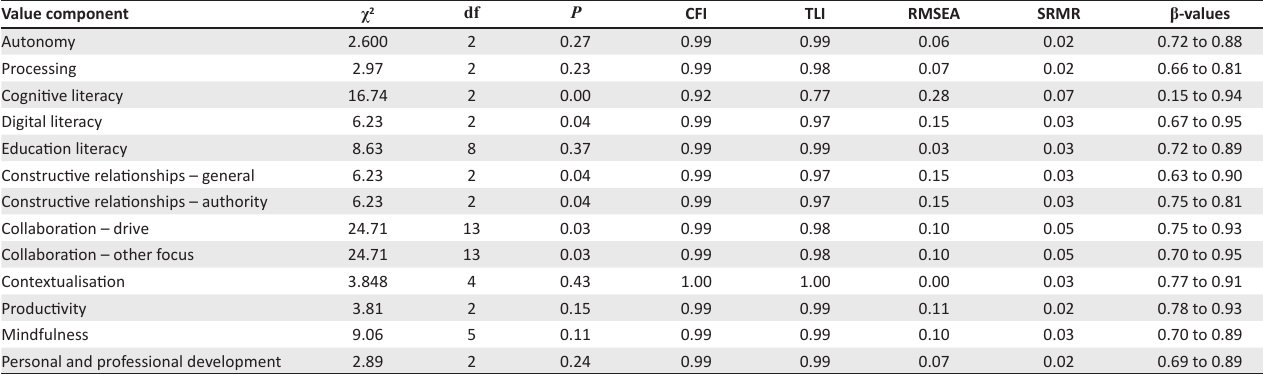
TABLE 3: Confirmatory factor analysis characteristics of the value component of each 21CC dimension. Value component